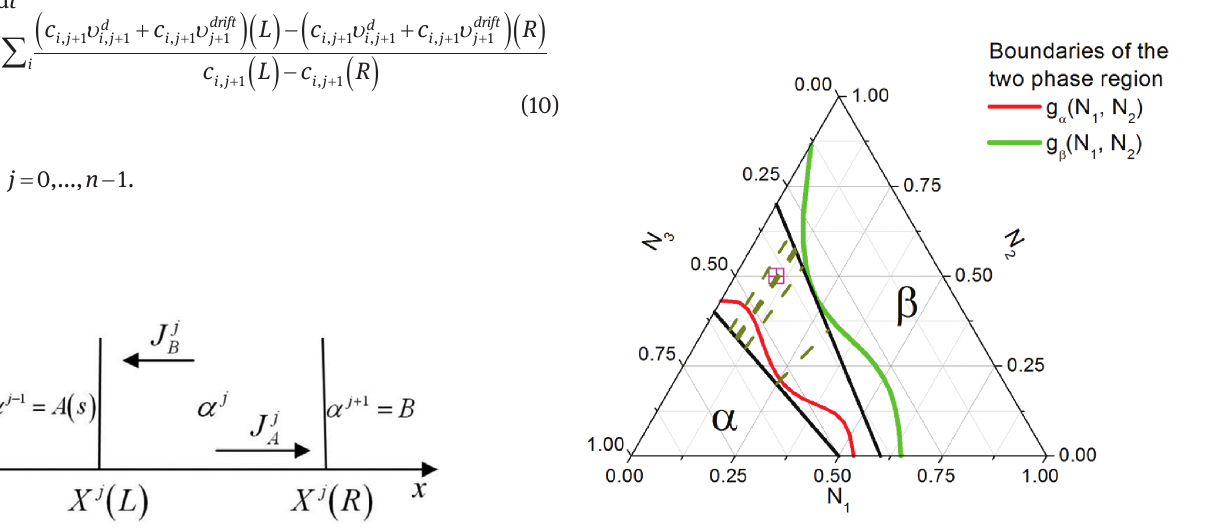
Fig. 1: The schematic presentation of the boundary conditions when low Zr content is